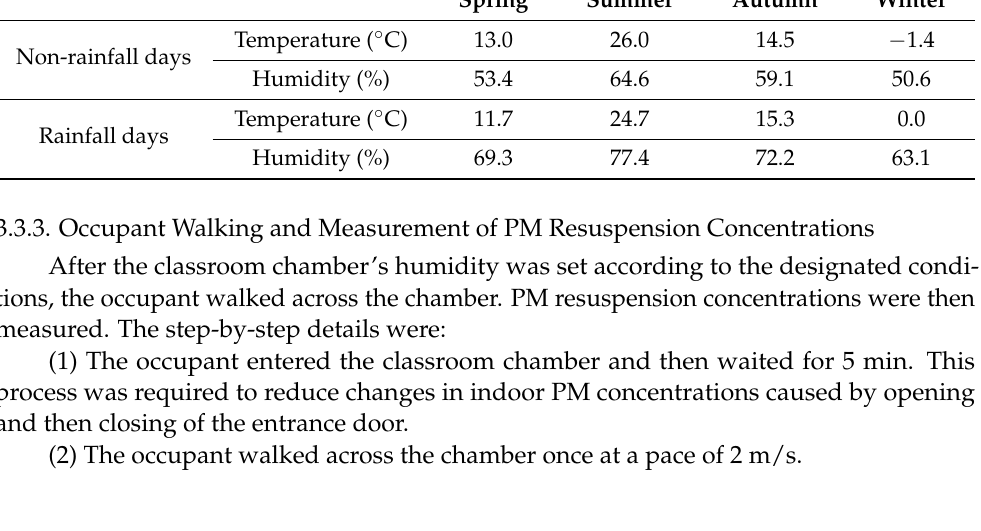
Table 4. Weather conditions in Seoul and Gyeonggi Province over the most recent three years.